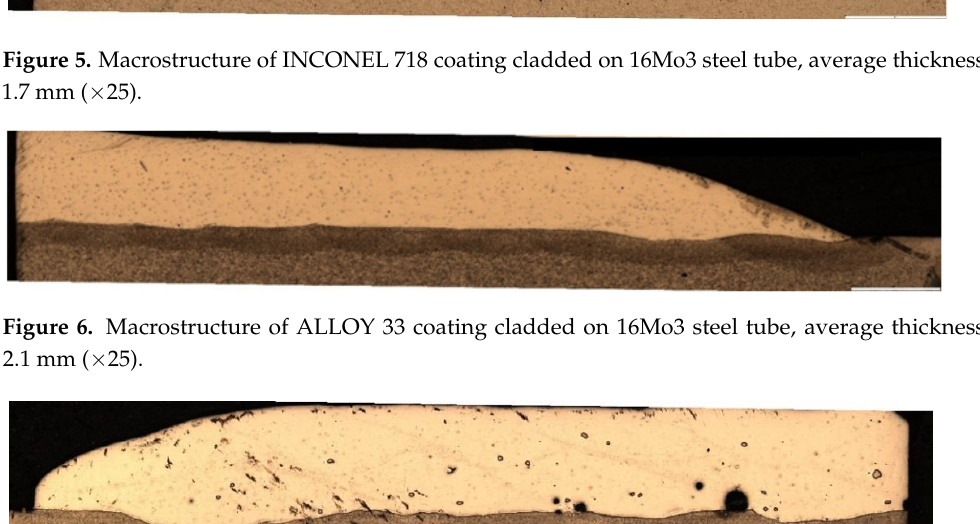
Figure 6. Macrostructure of ALLOY 33 coating cladded on 16Mo3 steel tube, average thickness 2.1 mm (×25).